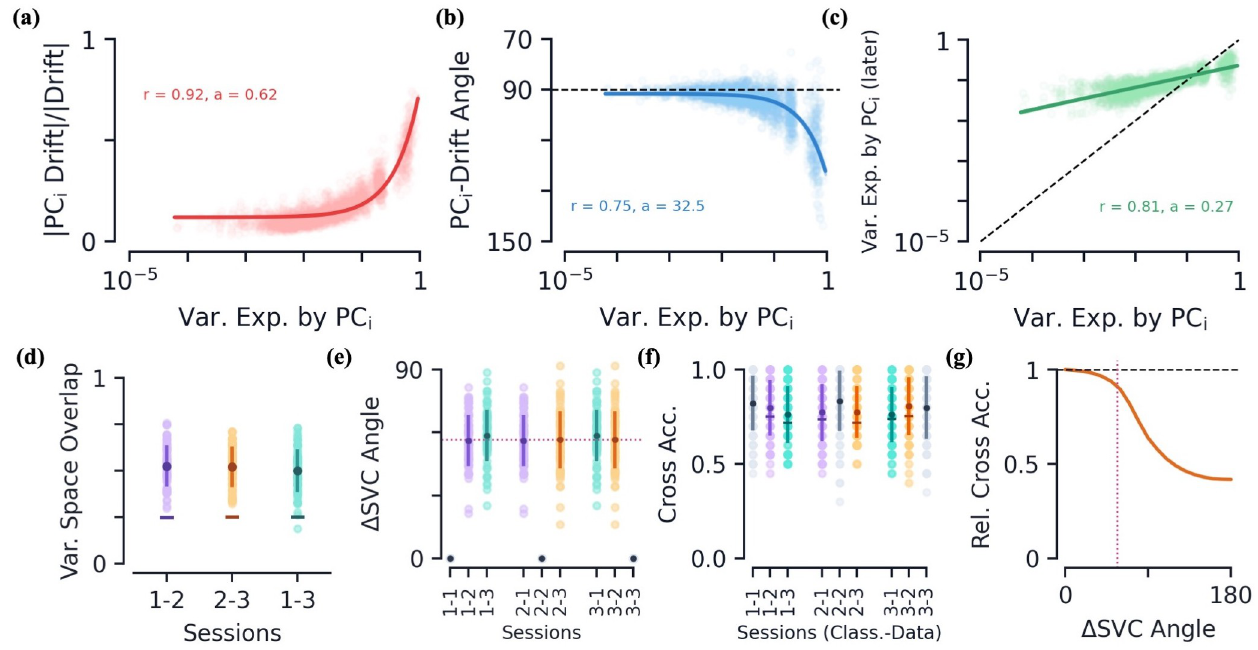
Fig 3. Passive data: Drift geometry and classifier persistence. [a-c] How various drift metrics depend on PC dimension of the earlier session’s variational space. Metrics are plotted as a function of PC i ’s ratio of variance explained, v i , across all stimulus groups. Colored curves are linear regression fits and shaded regions (often too small to see) are all fits within the 95% confidence intervals of slope and intercept. (a) Magnitude of drift along PC (L2) magnitude of drift. (b) Angle of drift with respect to PC i direction. (c) Post-drift variance explained along PC i direction, black dotted line is equality. Linear regression fit to log(var. exp.). [d-f] Various metrics and how they change between sessions. The darker dots/lines always show mean value with error bars of ± s.e. The lighter color dots show data from individual mice. (d) The variational space overlap between earlier and later stimulus groups, 0 � Γ � 1. The “–” marker indicates the average value of Γ for randomly oriented variational spaces of the same dimensions. (e) Angle between linear support vector classifiers (normal vector) trained on distinct sessions. The purple dotted line is the average angle between different sessions. (f) Cross classification accuracy as a function of trained data session (Class.) and tested data session (Data). The “–” marker shows average classification accuracy when SVCs are randomly rotated by same angle that separates respective sessions’ classifiers. (g) The relative cross accuracy, see Eq (14), as a function of the angle of a random SVC rotation. The purple dotted line is again the average angle found between drift sessions, also shown in (e).